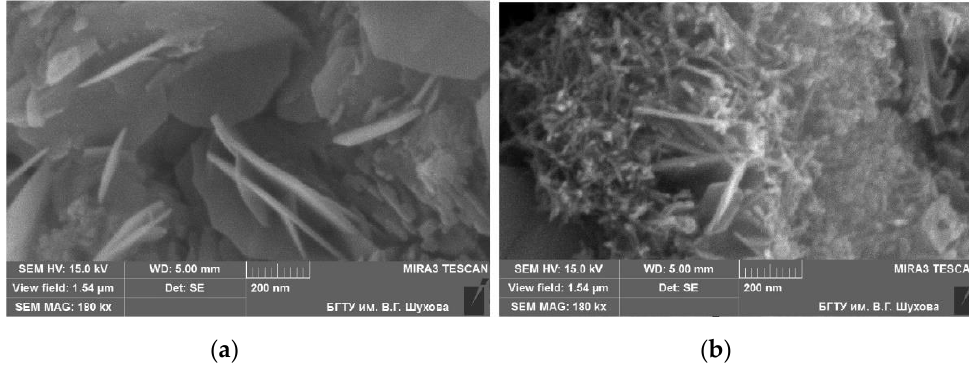
Figure 10. SEM images: ( a ) Mix ID 4, and ( b ) Mix ID 1.